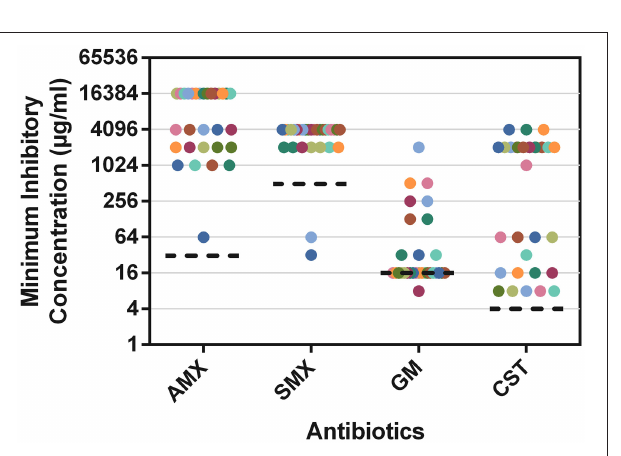
FIGURE 7 | The MICs of randomly selected isolates from WWTW, where each data point represents a single isolate. Mode MICs appear where data points cluster. Individual MICs, species identification and antibiotic exposure can be observed in Supplementary Table 2